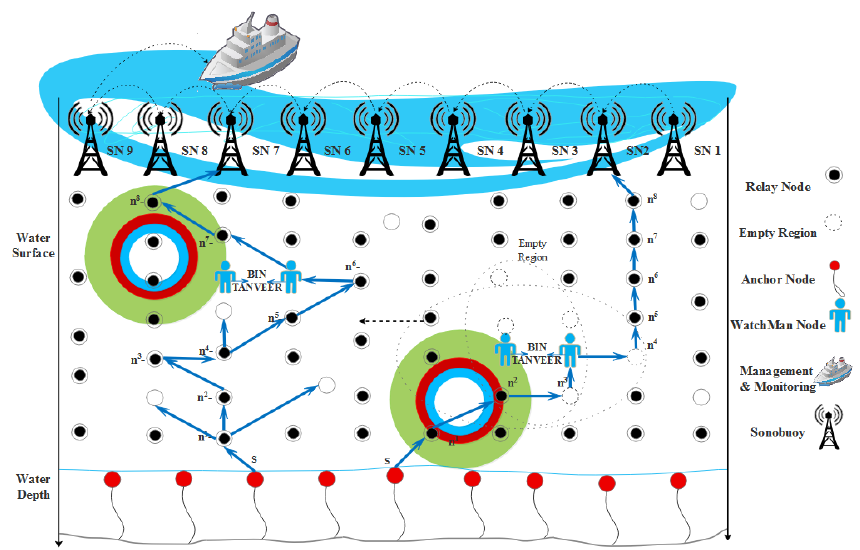
Figure 7. Working mechanism of binary inter nodes (BIN)-TANVEER with watchman nodes. It takes the data from the empty node like ‘ n 4 ’ and delivers them to the next available node. The recovery procedure works with looking forward to the least number of layer count and tries to find out the next nearest node in order to proposed mechanism energy efficient with all aspects. In this way, instead of dropping the packets and increasing the packet loss ratio of the overall network, BIN nodes are responsible for doing this every time. Therefore, they come into contact or active only when the empty regions are detected. Meanwhile, the detection of empty regions is done by receiving the ‘ P ACK ’ of the nodes as in Equation (6), and ‘ P CHG ’ is basically the function of BIN-TANVEER, and it used for the recovery procedure. In an exceptional case, if the availability of the node is not present around the empty regions, then BIN sends a data packet greedily to sonobuoys. Otherwise, it transfers the information to the nearest node for successful data communication among the network nodes. Figure 7 shows the working of BIN-TANVEER and Figure 8 represents the transmission adjustment of watchman, while Algorithm 3 depicts the proposed mechanism. Moreover, the flowchart of proposed scheme and its sub-sections are illustrated in Figure